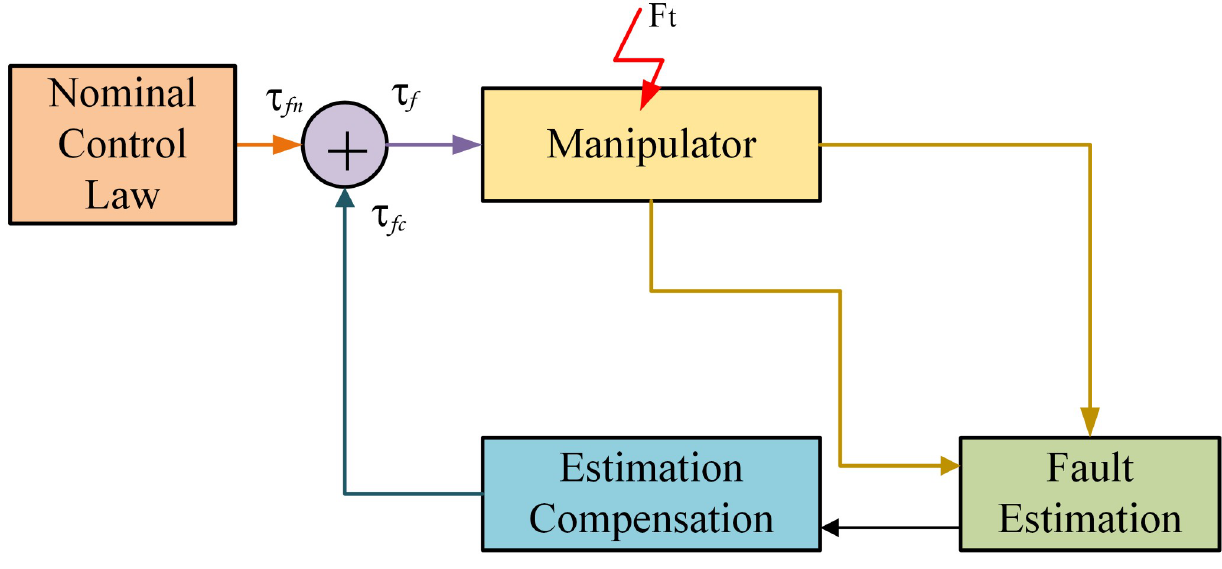
Fig 7. Actuator FTC design technique.